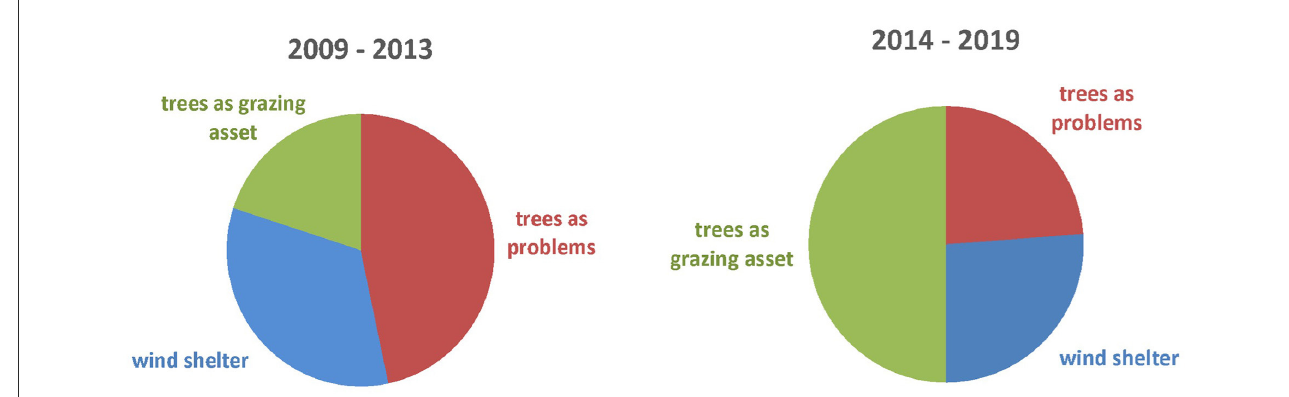
FIGURE4 Context of search terms (tree, wood, forest) in articles before and after January 2014, excluding articles about silvopasture or Graze advisors addressing heat stress. 2009–2013 n = 45 appearances of search terms in 50 issues; 2014–2019 n = 42 appearances of search terms in 56 issues.